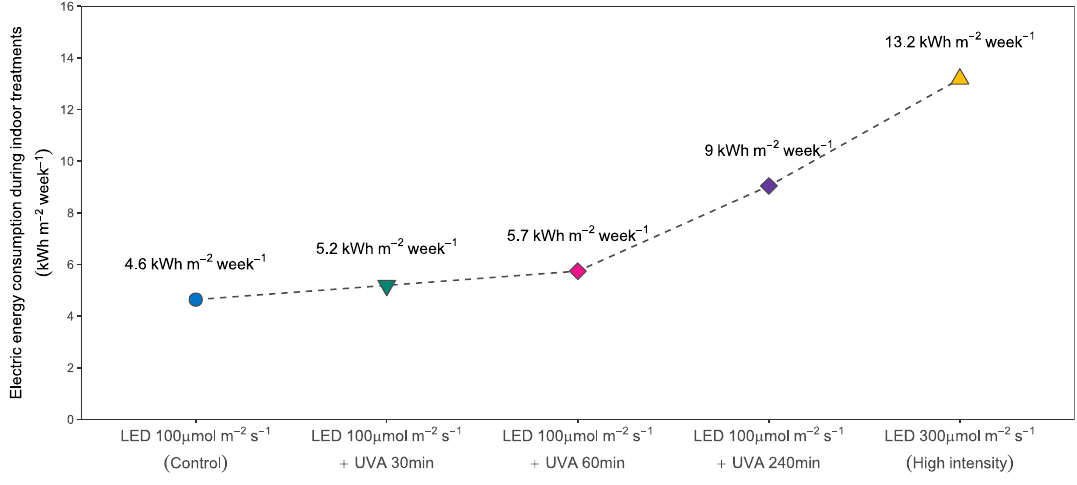
Figure 8. Electric energy consumption by the lamps during the indoor treatment. The figure shows the energy consumption in each treatment for 7 days expressed as kWh per m 2 of cultivation area.